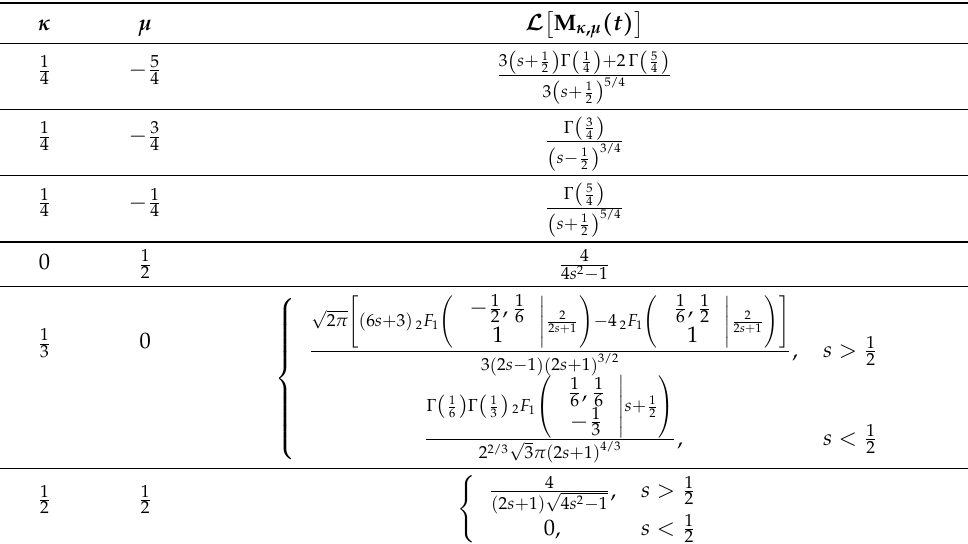
Table A8. The Laplace transforms of the Whittaker functions M κ , µ derived for some values of parameters κ and µ